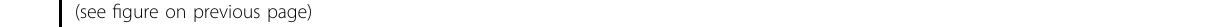
Fig. 3 The phenotypic heterogeneity of myeloid cells. a t-SNE plot showing a total of 15,366 myeloid cells, separated into 28 subtypes. b Cells are colored according to tissue origins (top) and treatment status (bottom). c Left, heat map showing normalized expression ( z -score) of function-associated genes in TAM subsets. Black boxes highlight the prominent patterns de fi ning TAM subtypes. Right, bar plot showing the tissue origin and treatment status of each TAM subtype. d Bottom, based on the annotation and classi fi cation above, bar plots depicting cell numbers of each cell type in tumors with or without PC treatment are shown. Top, pie charts showing the proportions of different TAM subsets within different tissues (the primary CRC, liver metastases). e Boxplot comparing the frequency of immature TAMs in treated and treatment-naïve patients both in primary CRC and liver metastases. Wilcoxon rank-sum test was used for statistical analysis. f Overall survival curves of TCGA COAD patients (Cox regression). We identi fi ed an M11 TAM signature composed of 26 genes that showed signi fi cantly increased expression in M11 vs other TAM clusters. g Immuno fl uorescence analysis showing M11 (S100B + MMP122 + CD68 + ) cell numbers in tumors treated with or without PC. h Boxplot showing the levels of M11 signature in pretreated samples from the human colorectal cancer dataset GSE12246, adjuvant chemotherapy 86